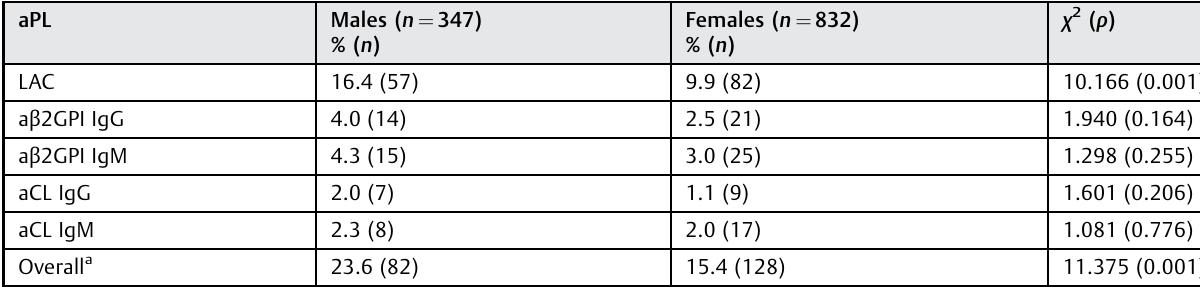
Table 5 Positivity prevalence by